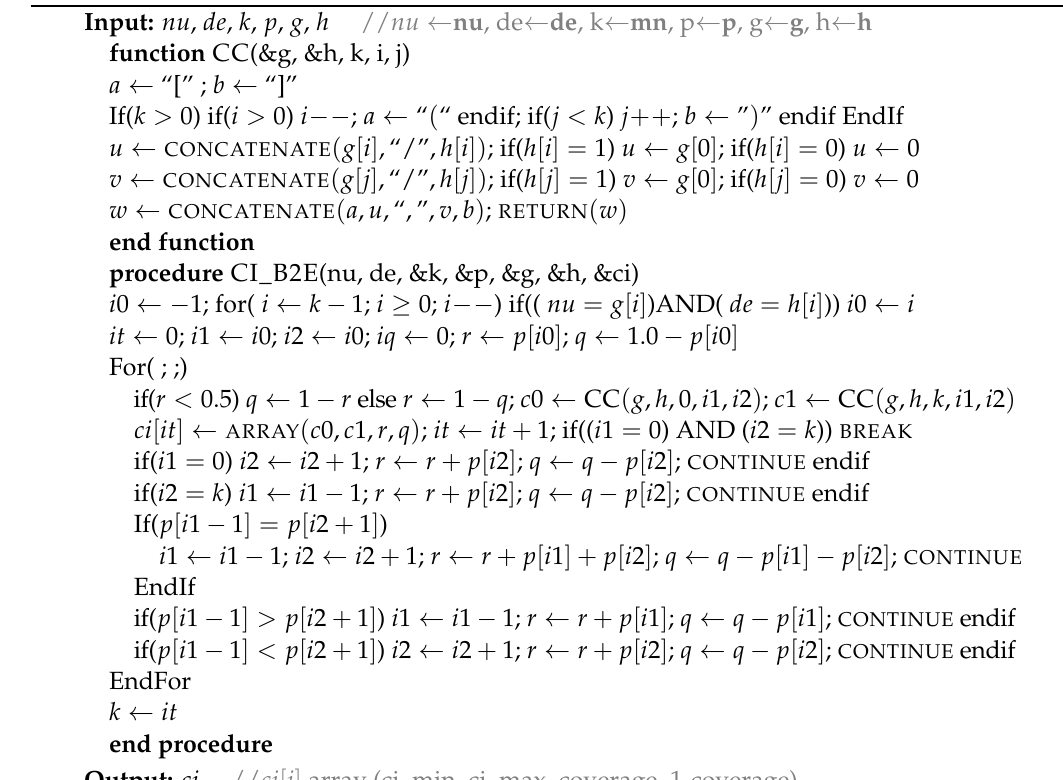
Algorithm 5: CIs in increasing coverage for